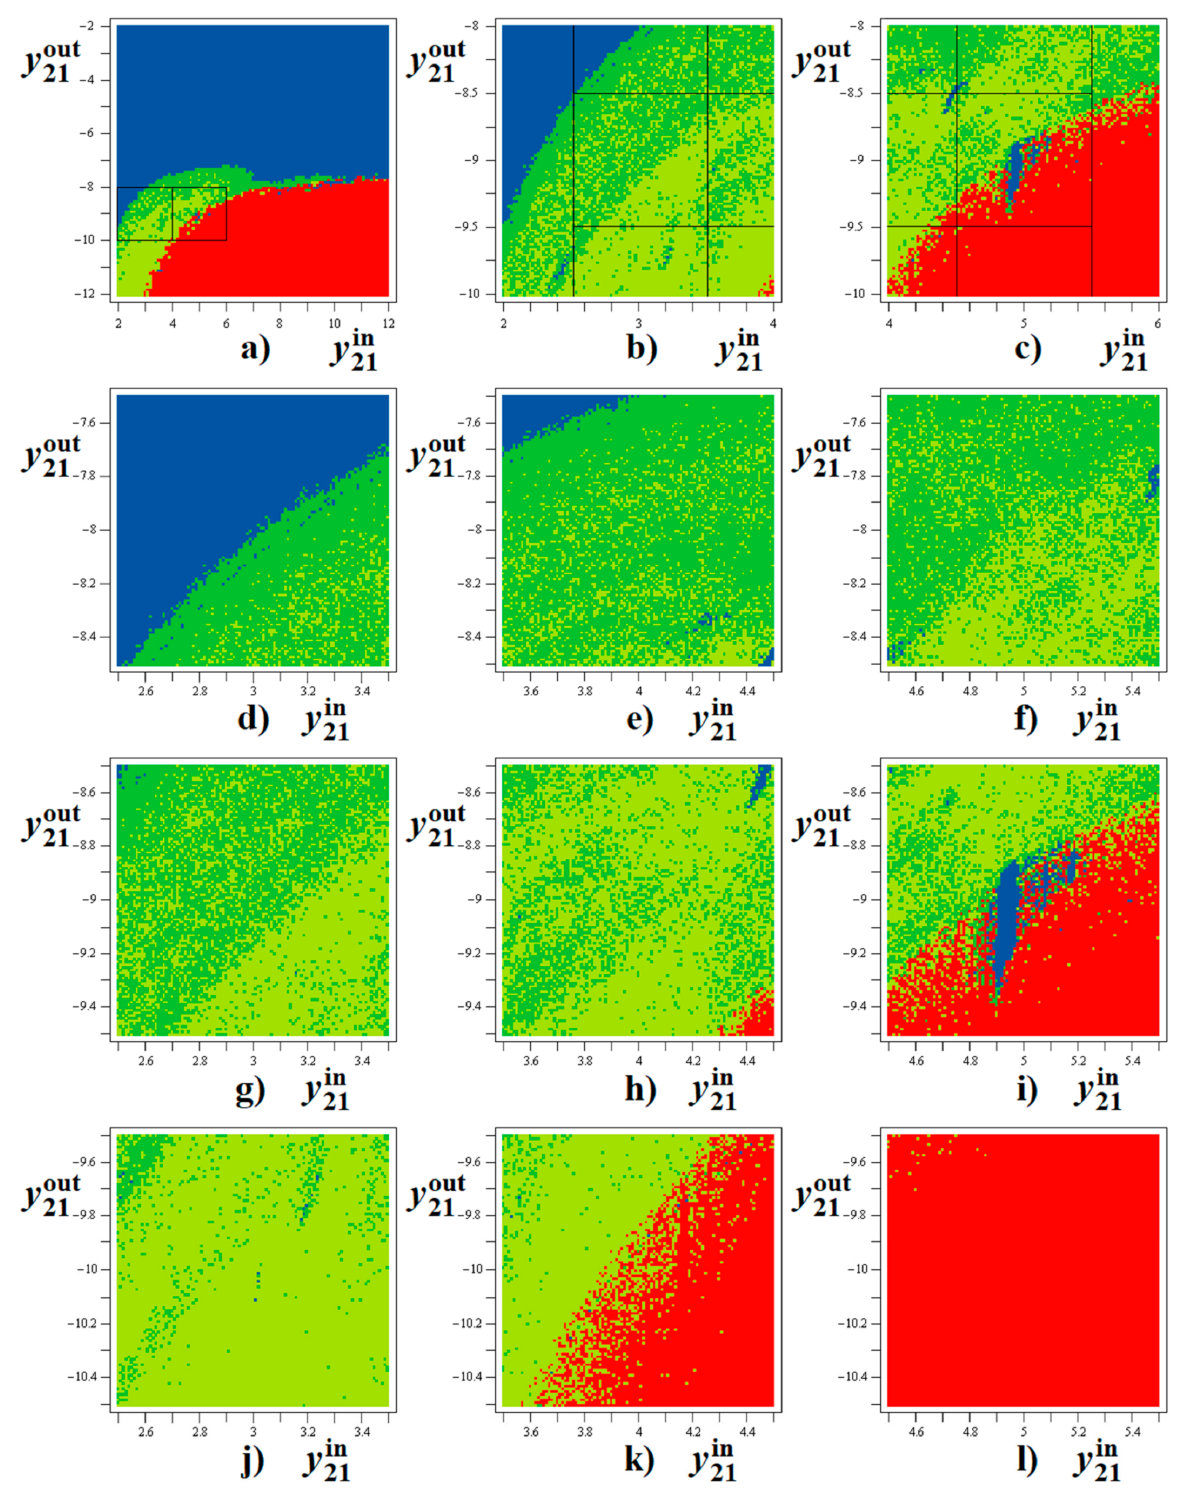
Figure 7. Clapp oscillator, Case II, individual colors represent different types of dynamical behavior driven by fixed point located at origin: unbounded solution (red), hyperchaos (light green), chaos (dark green), and limit cycle (blue). Figure ( a ) contains fragments ( b , c ), and these parts cover ( d – l